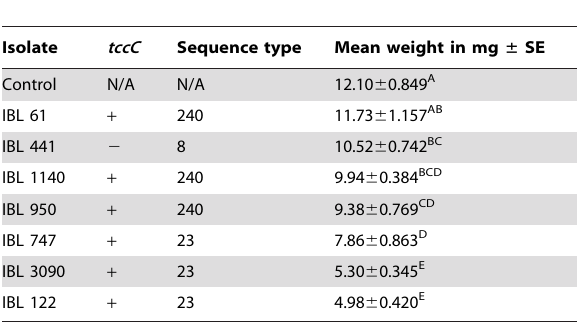
Table 2. Weights of Colorado potato beetle larvae fed whole cultures of tc -positive and tc -negative B. thuringiensis isolates.